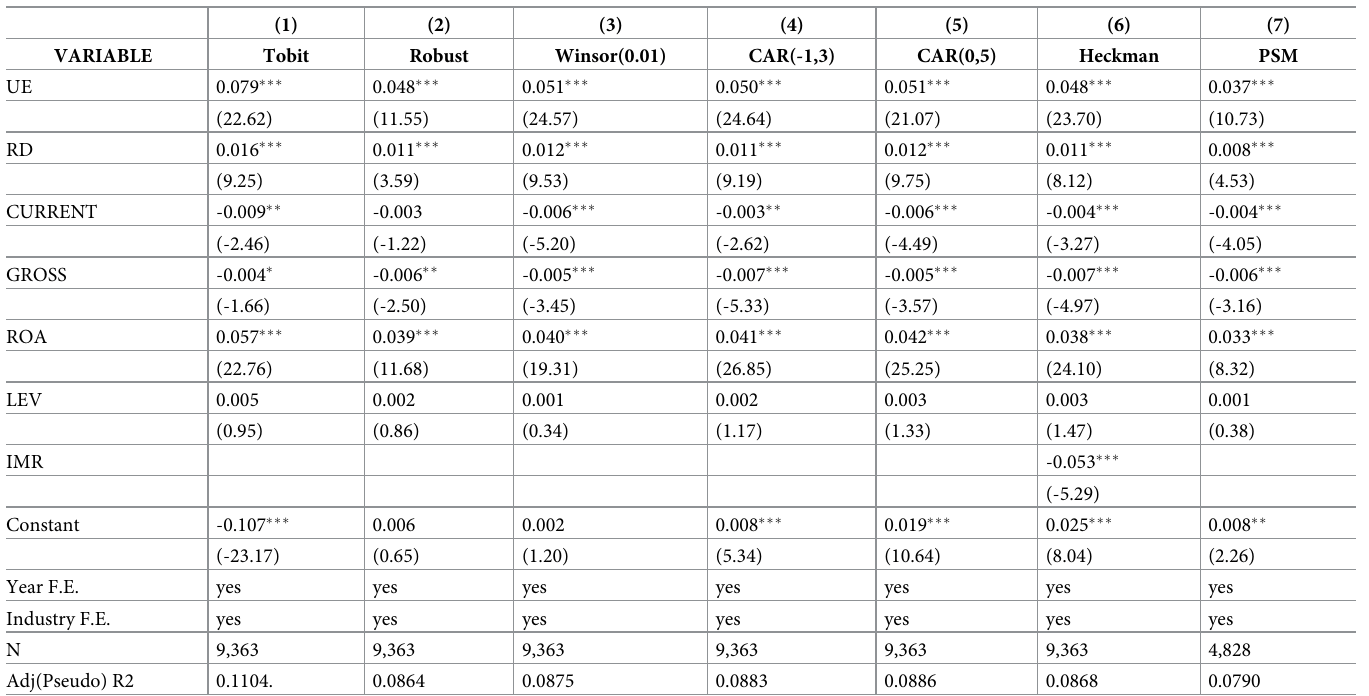
Table 4. Robustness